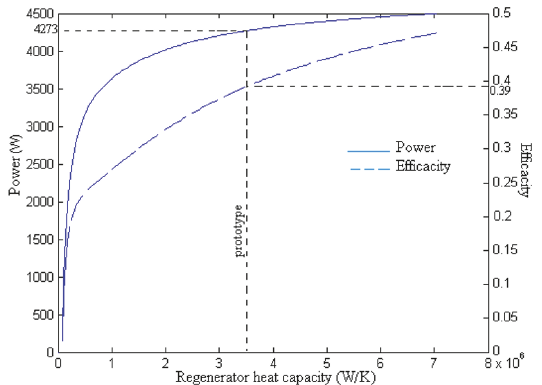
Figure 11: Power and efficiency variation with regenerator section conductivity.